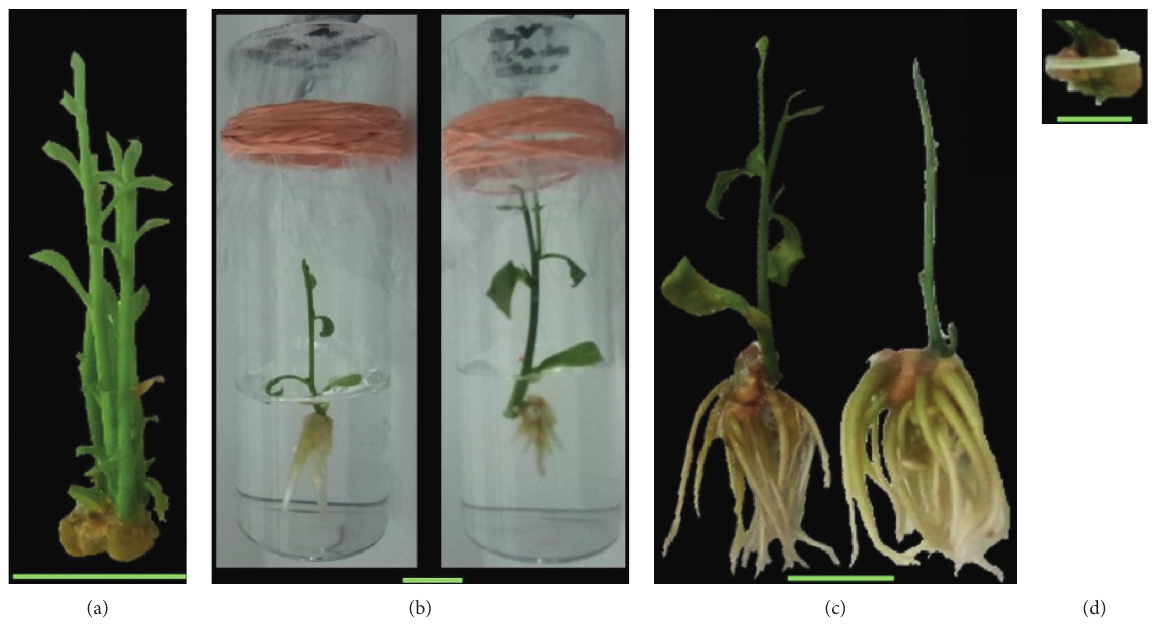
Figure 6: The rooting results. (a) Three shoots just before inserting in the rooting medium; (b) shoots form roots; (c) rooted plantlets removed for subculturing; (d) bottom enlargement